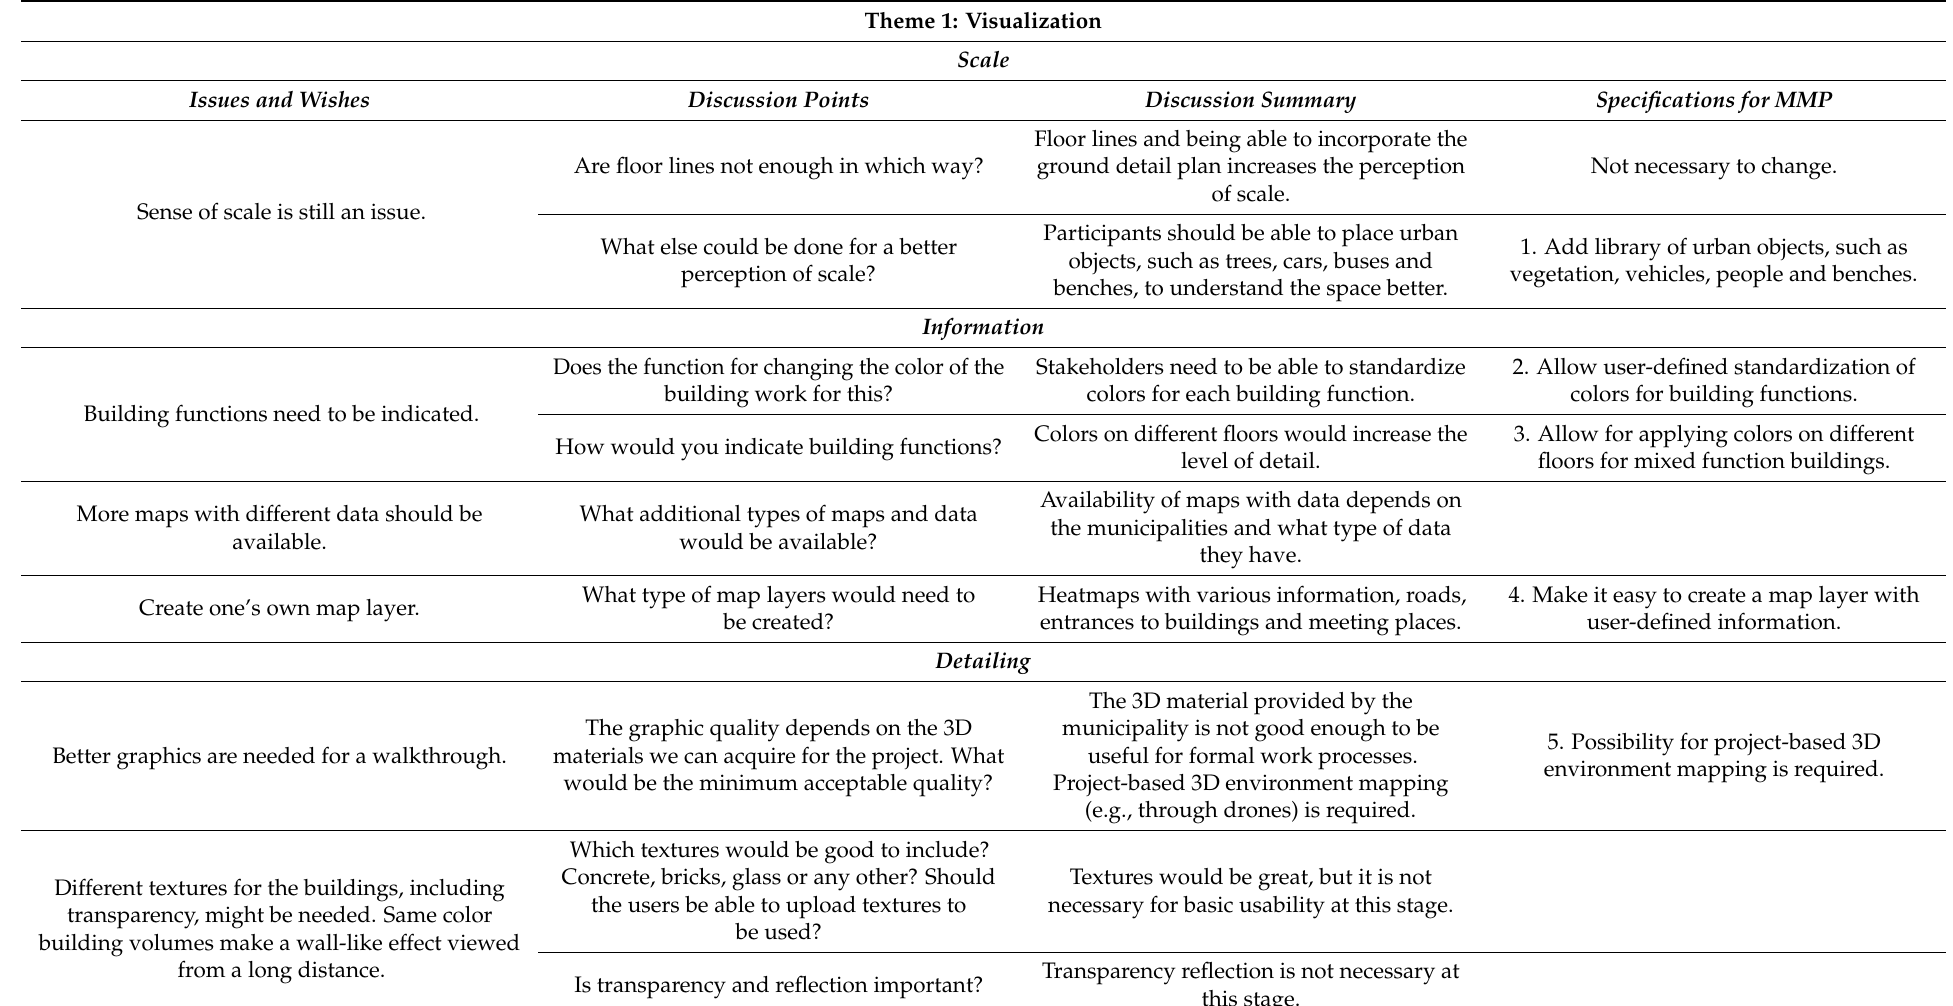
Table 3. Sequence for developing detailed specifications for the